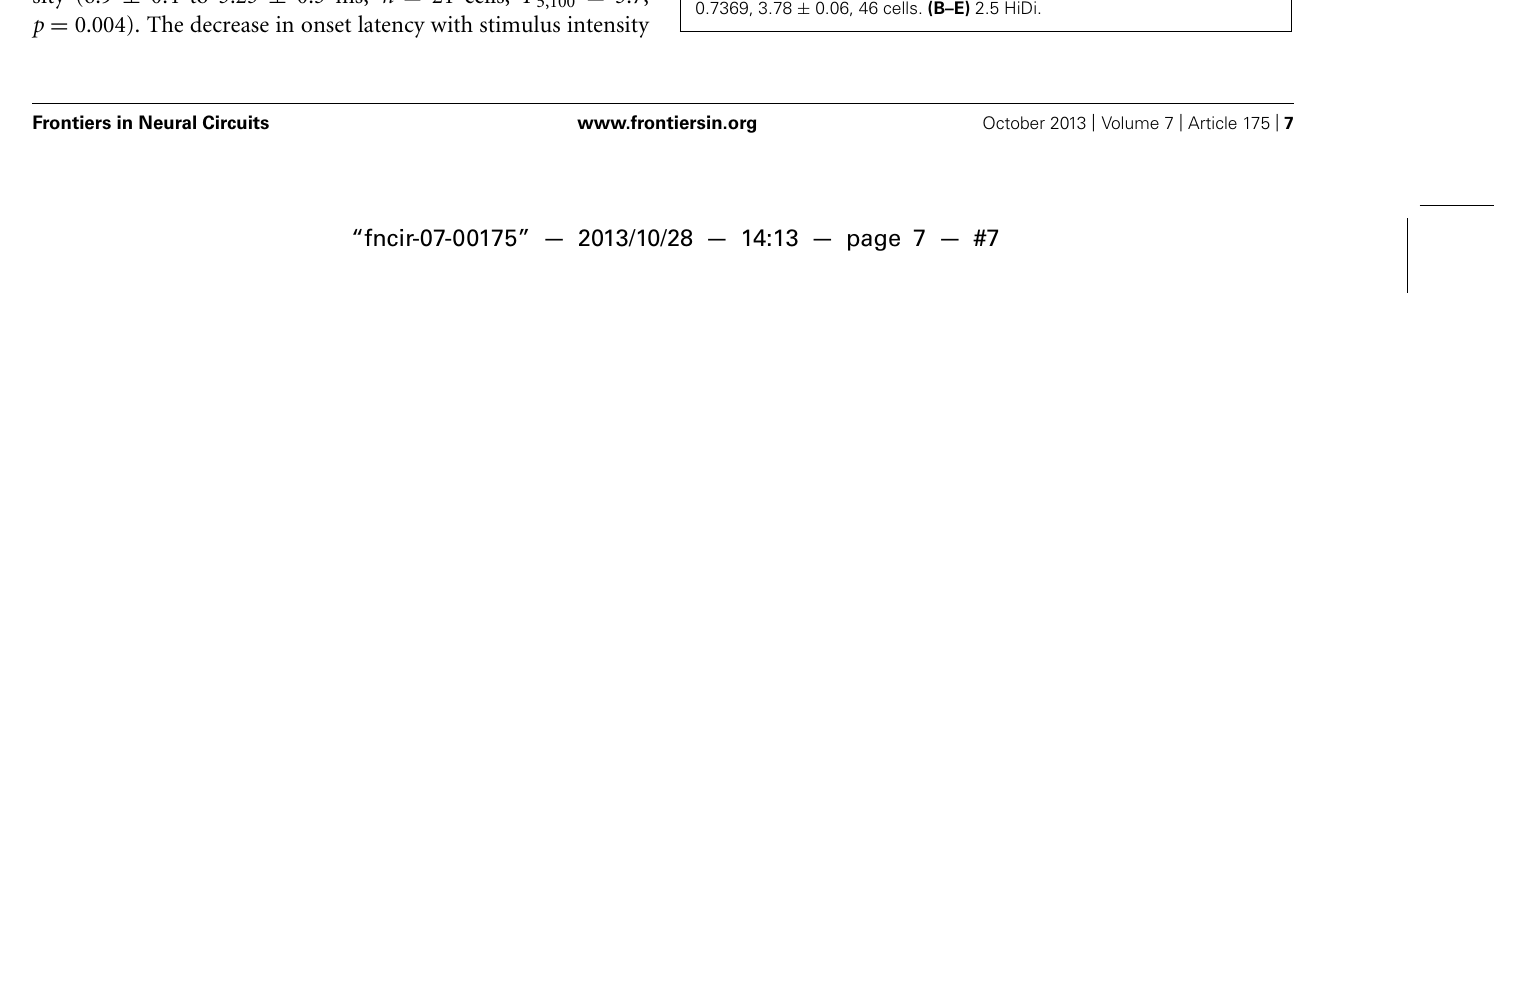
FIGURE 1 | Continued HiDi concentration effects on intrinsic membrane properties. (A) Transverse IC slice with patch electrode (R) for current injection and voltage recording. SC: superior colliculus; DL: dorsal nucleus of the lateral lemniscus; LL: lemniscal tract. Slices were bathed in different HiDi concentrations. (B) Intrinsic firing evoked by current steps. Sustained-regular cell (postnatal day 26). Left, middle: firing patterns remained sustained in 2.5 HiDi. Right: at higher divalent strengths ( ≥ 3.5 HiDi), spikes shortened and aborted (asterisks).When spiking did occur, firing remained sustained. Current steps are at the bottom of each column. Voltage responses are illustrated to three depolarizing and two hyperpolarizing current steps. Depolarizations increase from top to bottom; responses to the two hyperpolarizing currents are superimposed. Hyperpolarizing current steps were kept the same in ACSF and HiDi; depolarizing currents were increased in HiDi to evoke either roughly the same number of spikes as in the control (2.5 HiDi) or to cross firing threshold (4 HiDi). Currents were < 0.5 nA to prevent membrane rupture, therefore spike frequencies in 4 × HiDi did not reach control rates. (C–E) Summary of intrinsic membrane properties in control ACSF (C) and different HiDi concentrations. (C) Sustained-regular cells (P15–23). (D) Top, middle: sustained regular cells; Bottom: sustained-regular and rebound-adapting cells. (E) Data pooled from different intrinsic cell types. Cell type nomenclature from Sivaramakrishnan and Oliver (2001). (C) Spike characteristics. At ≤ 3 HiDi, spike frequencies, inter-spike intervals, and spike heights were normal, ≥ 3 HiDi lowered spike frequencies, increased inter-spike intervals and decreased spike heights, 16 cells. Mean and SEM ANOVA for ACSF/2, 2.5, 3, 3.5, 4 HiDi. Spike frequencies: F 6,90 = 2.82; p = 0.01; Inter-spike intervals: F 6,90 = 2.87; p = 0.01. Spike heights: F 6,90 = 3.01; p = 0.01. (D) Passive membrane properties in HiDi.Top: input resistance (R) plotted for one sustained-regular cell. Same cell as in (B) . Membrane potentials (ordinate) are relative to the resting membrane potential. Shaded area: the range of membrane potentials resistant to HiDi. Middle: average input resistances, 18 neurons. Mean and SD. Paired t -tests: ACSF, 2, 2.5, 3 HiDi, p > 0.33 in each condition. Input resistances deviated at larger hyperpolarizing currents; p < 0.004. Bottom: membrane time constants in control ACSF (C) and 2.5 HiDi shown for individual sustained regular cells (SR; left) and rebound-adapting (RA) cells (right). Eight cells in each panel. (E) Effects of HiDi on threshold.Top: injected current at which spike threshold was reached; Middle: membrane potential at threshold; Bottom: rate of rise of membrane voltage to threshold. Mean and SD 24 cells. Seven sustained-regular, 12 rebound, 5 pause-build. ∗ p < 0.01; ∗∗ p < 0.001; ∗∗∗ p < 10 − 5 .